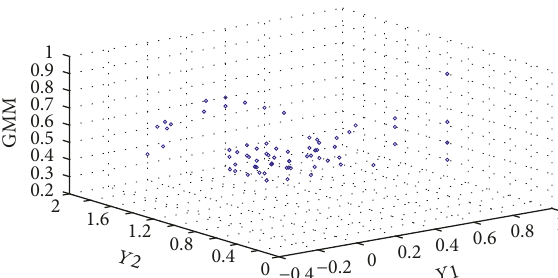
Figure 8: The interface damage